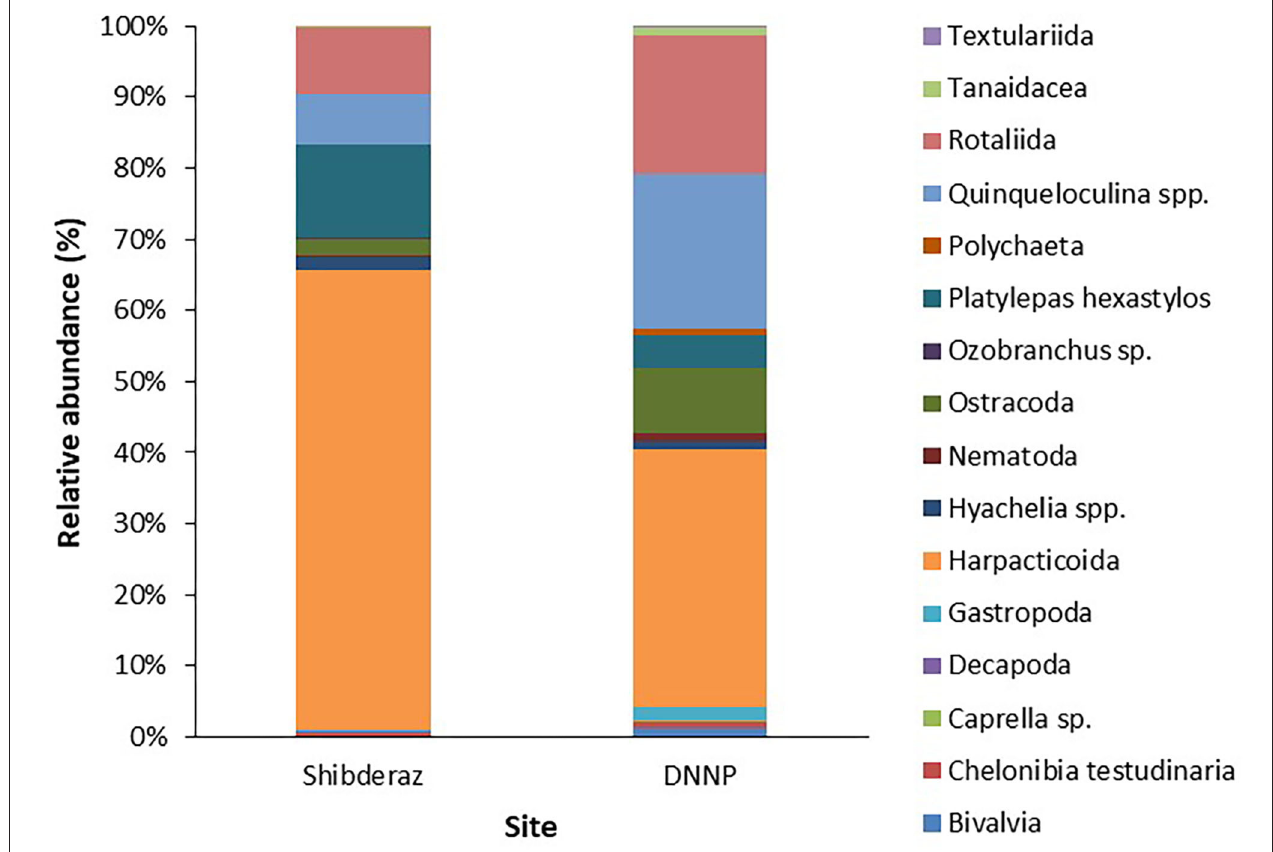
FIGURE 3 | Relative abundance (%) of epibiont taxa on the body surface of the nesting hawksbill turtles in Shibderaz and Dayyer-Nakhiloo National Park (DNNP).